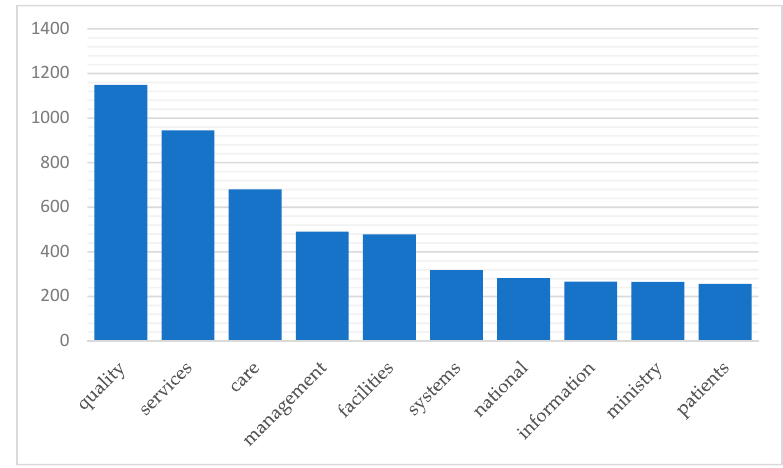
Figure 3. The top ten frequently used words (x-axis) in the Vietnamese Ministry of Health’s Joint Annual Health Report 2012 (y-axis: number of appearances). The results were obtained from the text mining of the ministry’s reports in R software (version 3.4.1).